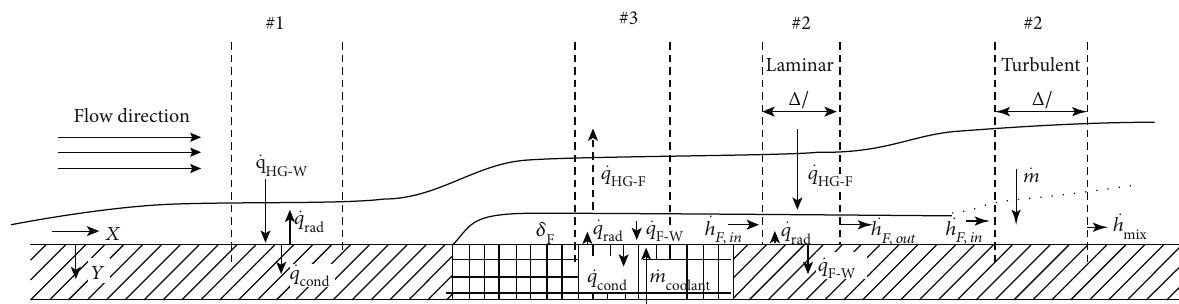
Figure 11: HEATS heat balance concept for transpiration cooling [18].